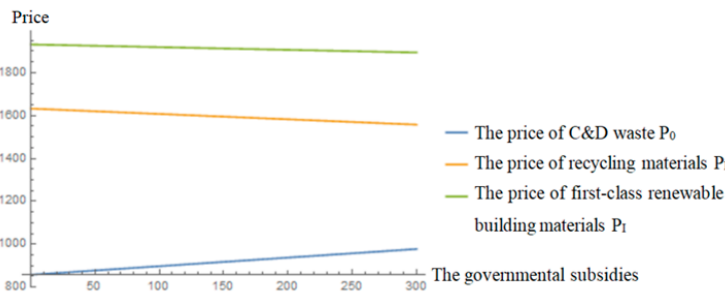
Figure 7. Effects of governmental subsidies on the prices.